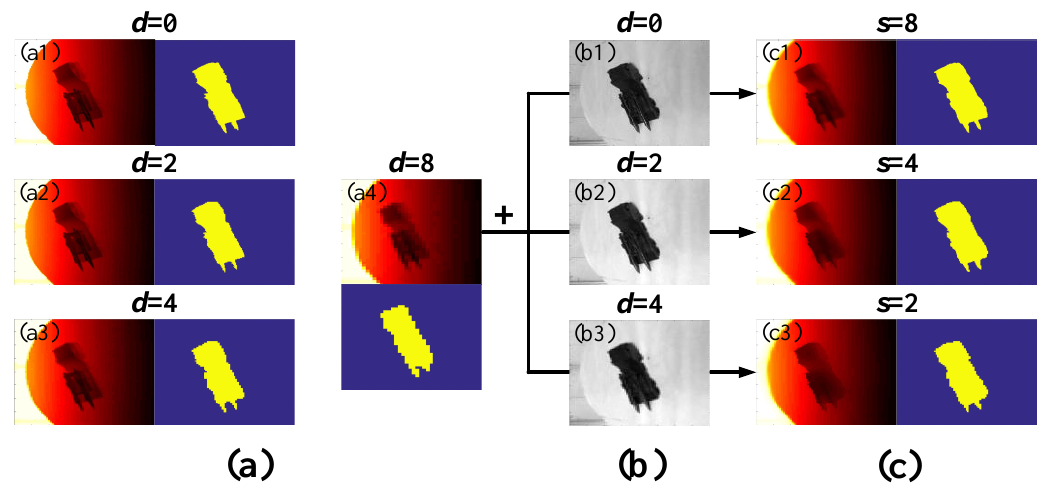
Figure 9. Explanation of the experiment phenomenon. ( a ) OHRRI and its down-sampled images. ( b ) OHRII and its down-sampled images. ( c ) Super-resolved images of the original low-res range image (OLRRI).